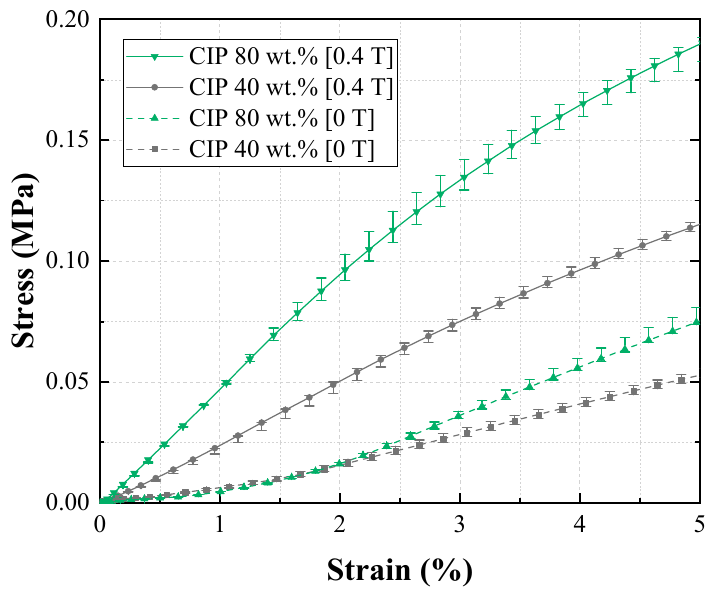
Figure 11. Effect of the CIP concentration of the MRE layers on Young’s modulus.